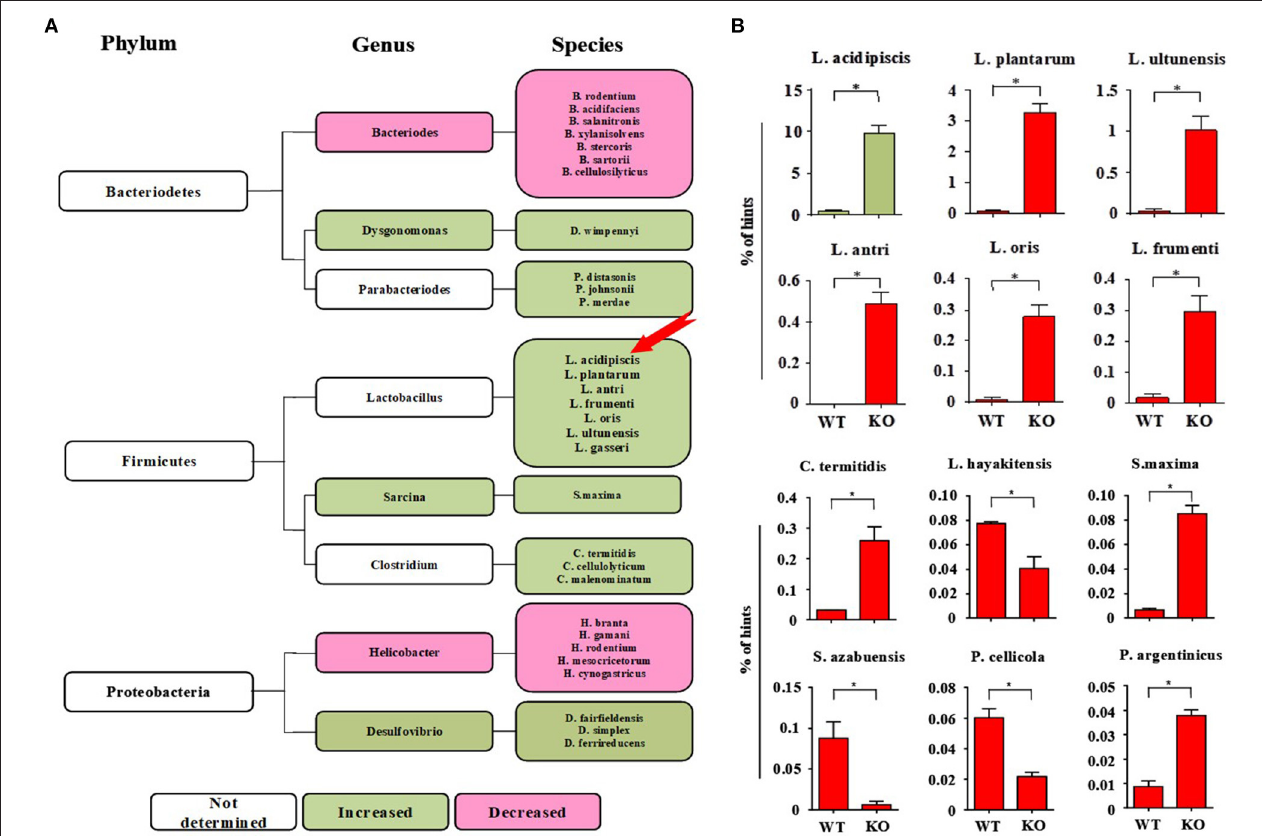
FIGURE 1 | The number of L. acidipiscis bacteria was significantly increased in EAE- resistant mice. (A) Plots of the intestinal flora compositions of CD44KO and WT mice. The number of lactobacilli and number of desulphurized vibrio bacteria were higher than of WT mice in the intestinal tract of CD44KO mice, while those of bacteroidetes and helicobacter were lower. (B) The number of L. acidipiscis bacteria was significantly increased in CD44KO mice, and L. acidipiscis was the predominant lactobacillus in the intestinal flora of EAE- resistant mice. C57BL/6 wild-type and CD44KO mice are labeled as WT and KO, respectively. Data are shown as mean ± SD and are from a single experiment representative with three mice per experimental group, comparisons were made between EAE WTs ( n = 3) vs. EAE KOs ( n = 3). * P < 0.05, Student’s t -test.